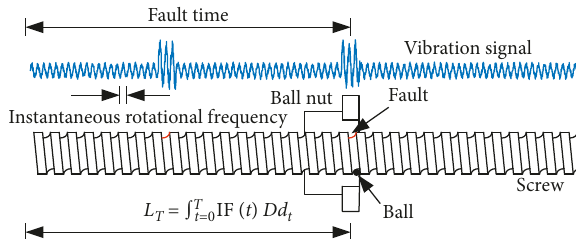
Figure 1: The structure of a ball screw